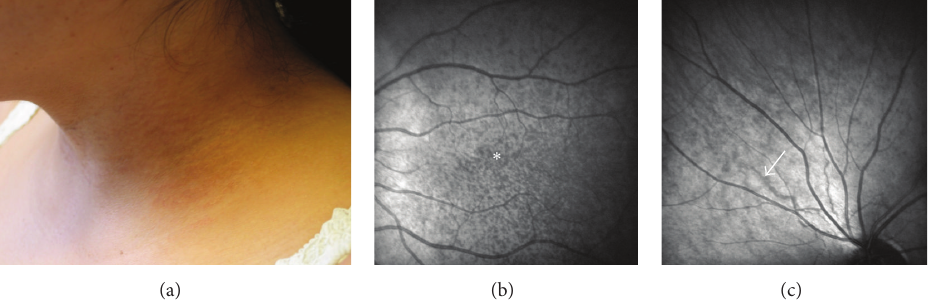
F 8: Clinical features of a patient with beta-thalassaemia and PXE lesions. e small papules on the lateral side of the neck are indistinguishable from hereditary PXE (a). In fundo, peau d’orange (b, asterisk) and angioid streaks (c, arrowed) can be seen as in classic PXE (HRA infrared imaging).